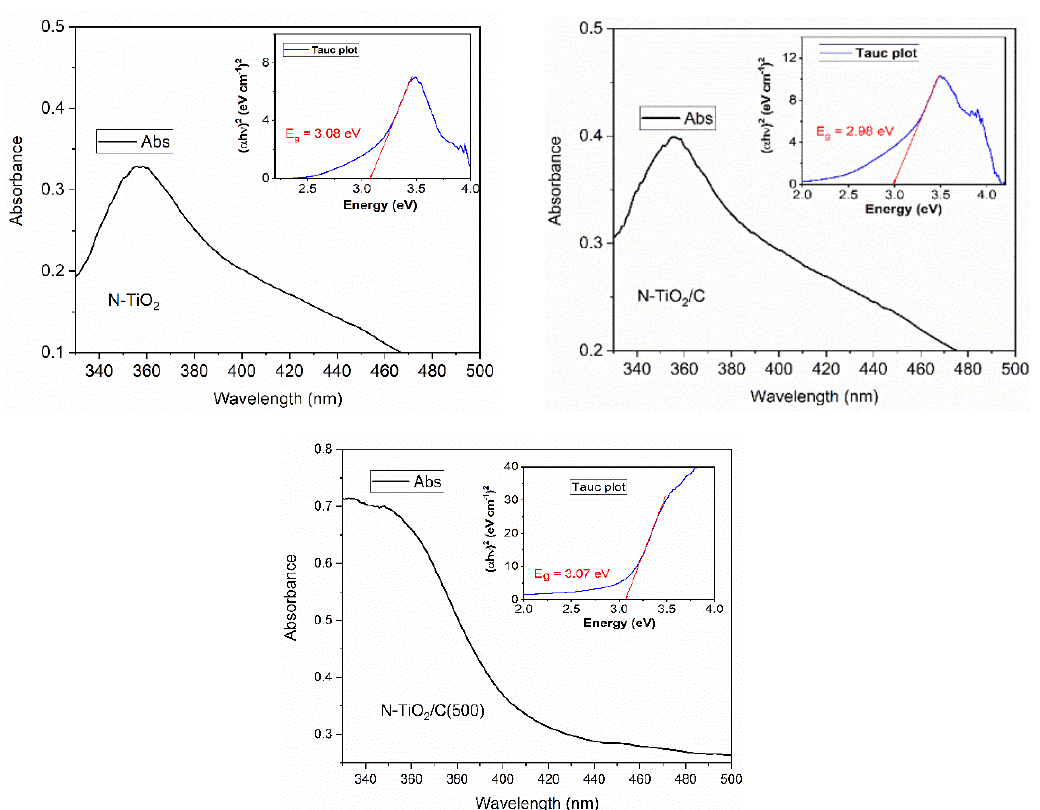
Fig. 8 Diffuse reflectance UV‐visible spectra of N ‐TiO 2 , N ‐TiO 2 /C and N ‐TiO 2 /C(500); inset diagrams show the Tauc plot and band gap calculation.